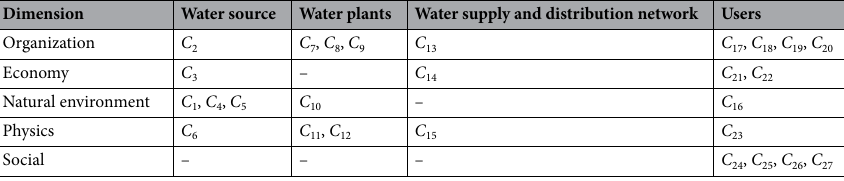
Table 5. Index system for resilience capacity